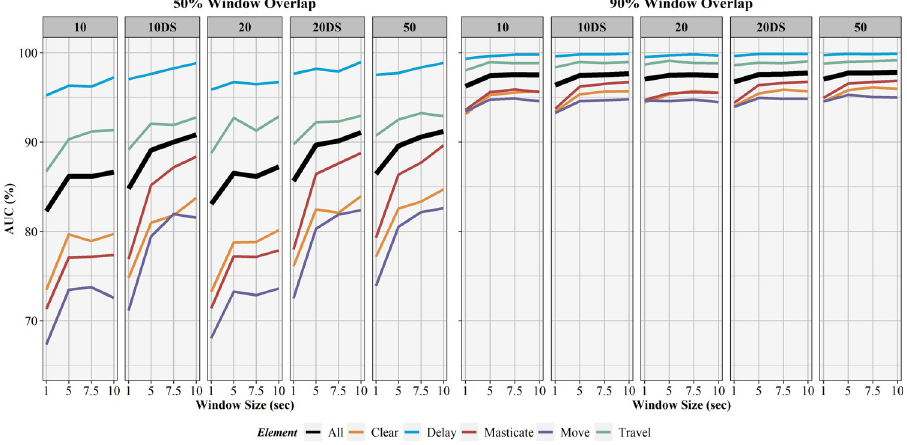
Fig 5. AUC results for activity recognition models. Comparison of activity recognition model area under the curve (AUC) percentages for 50% and 90% sliding window overlaps across the four sliding window lengths (1, 5, 7.5, 10 seconds) for each work element (clear, delay, masticate, move, travel) and for full models